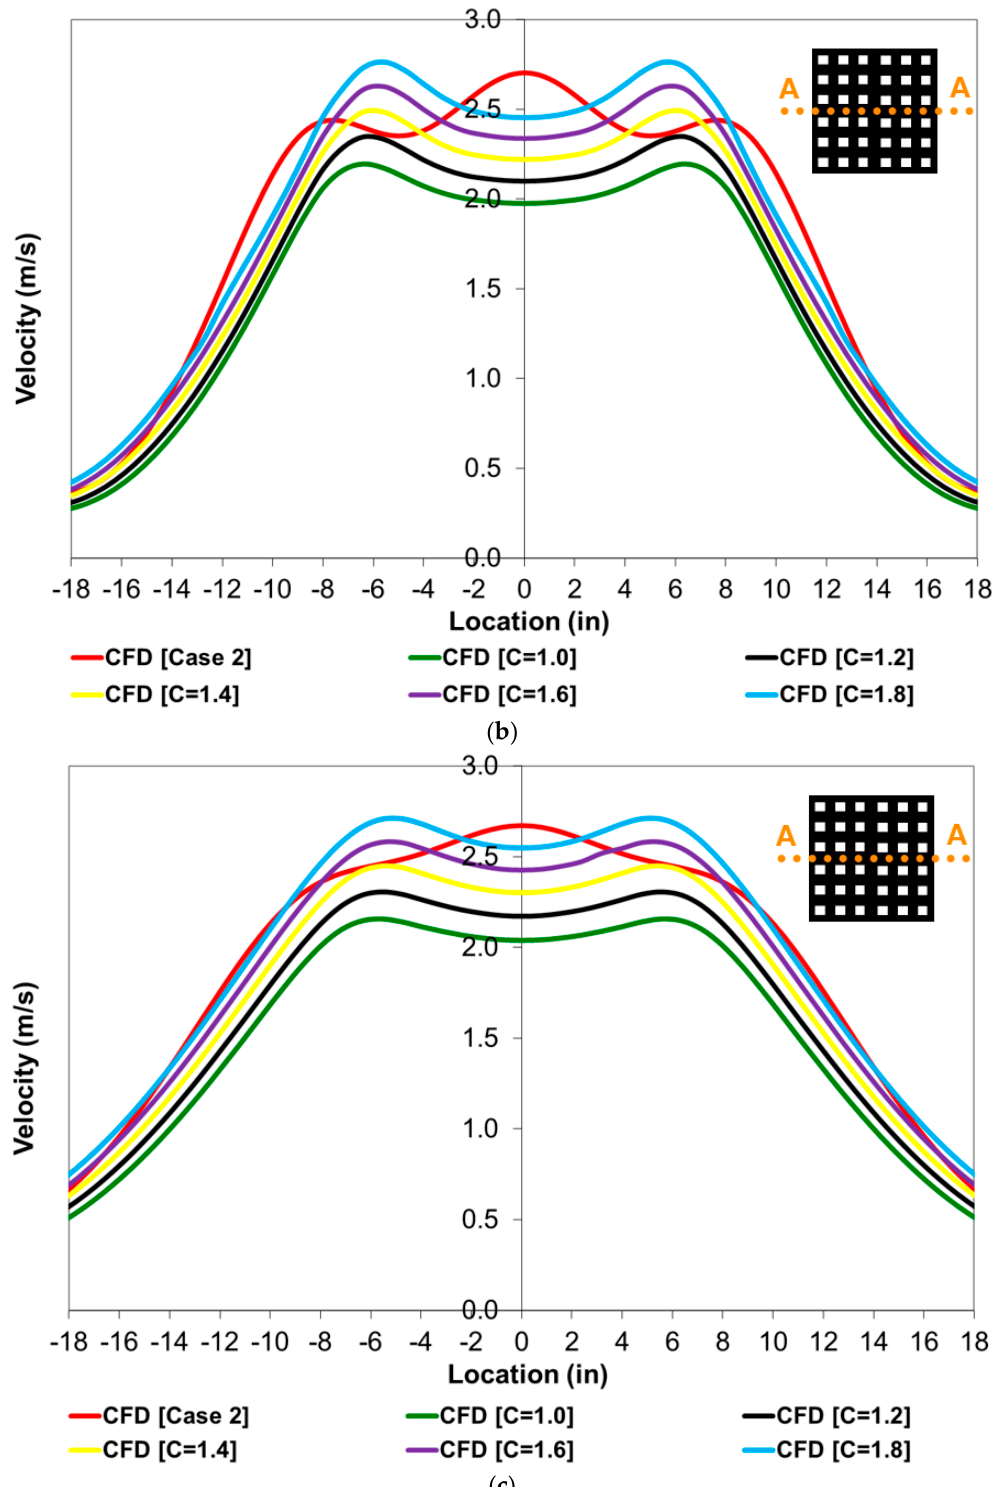
Figure 9. ( a ) Velocity profiles at 1 ft height along line A ‐ A for Case 2 and momentum source model results at different C values. ( b ) Velocity profiles at 2 ft height along line A ‐ A for Case 2 and momentum source model results at different C values. ( c ) Velocity profiles at 3 ft height along line A ‐ A for Case 2 and momentum source model results at different C values.